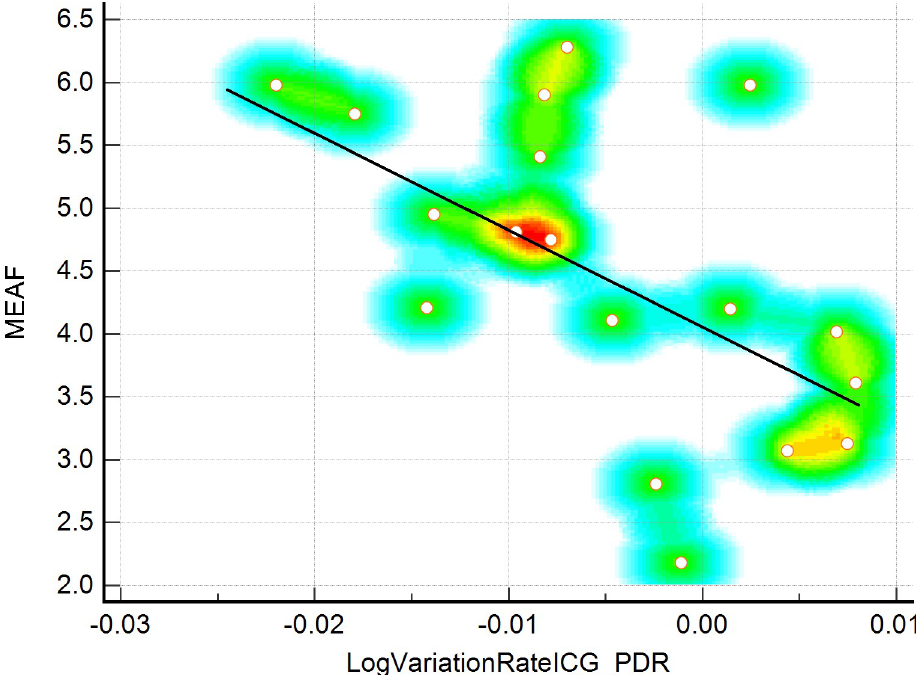
Fig 1. Estimation plot for paired ICG-PDR